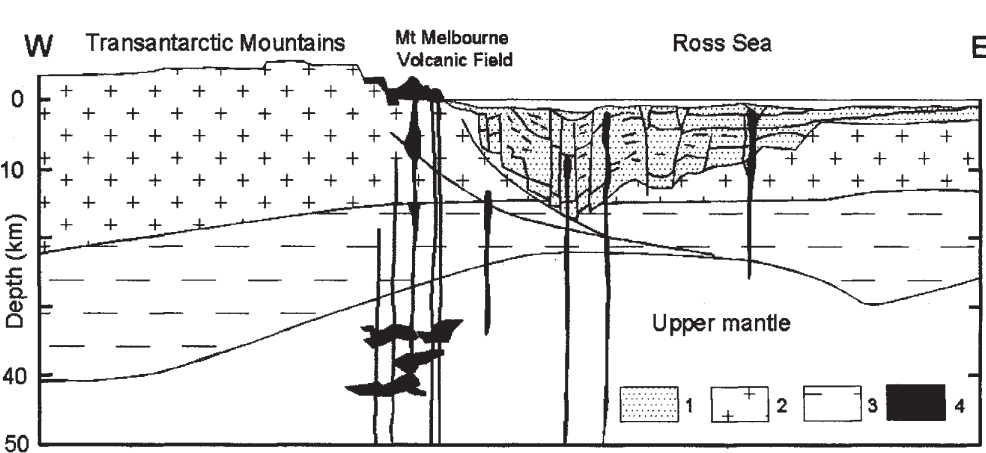
Fig. 2. Schematic cross-section of the lithosphere showing the transition from the Ross Sea rift to the Transantarctic Mountains, based on geophysical data, xenolith evidence and information from volcanic rocks (Wörner, 1999). 1. Sediments, 2. Upper crust, 3. Lower crust, 4. Mt Melbourne Volcanic